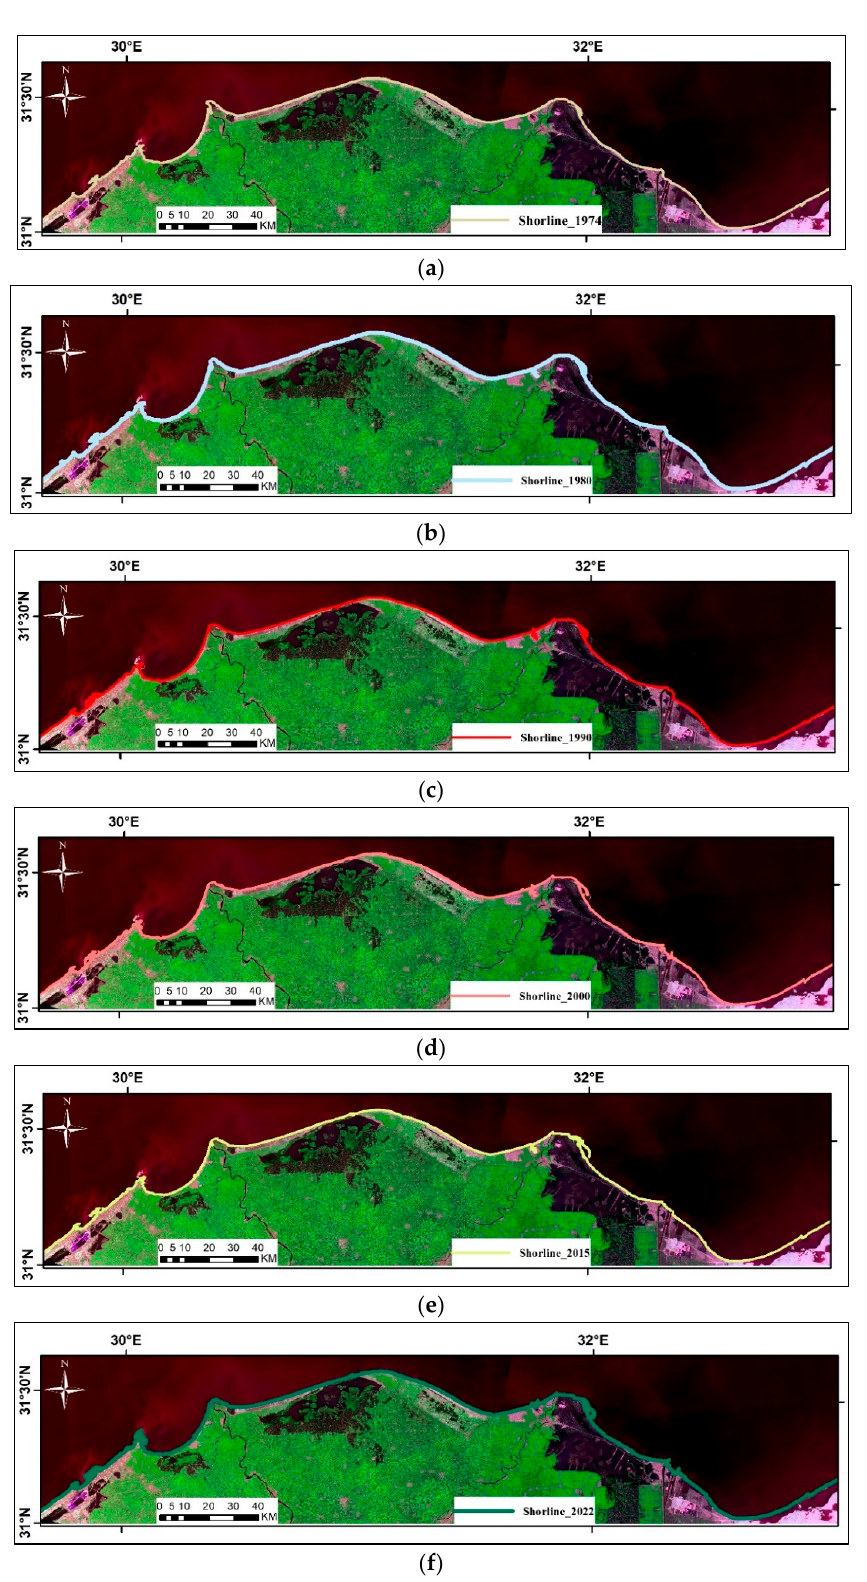
Figure 4. The historical trend of the Nile Delta shoreline for the period 1974–2022: ( a ) 1974, ( b ) 1980, ( c ) 1990, ( d ) 2000, ( e ) 2015, ( f ) 2022.